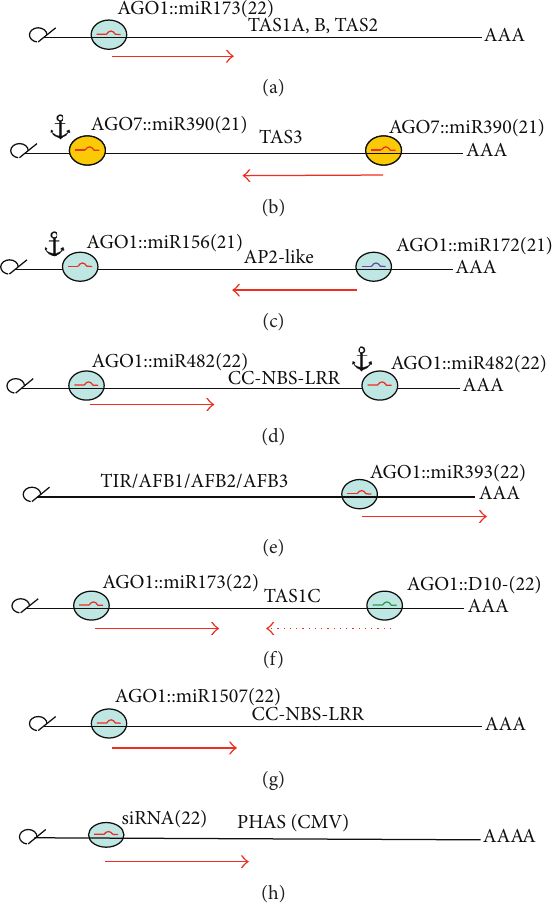
F 7: Examples of ta-siRNA and pha-siRNA production. Numbers in parentheses indicate the size of the sRNA considered. the red arrow intends to indicate the direction of transitivity. For details, see the